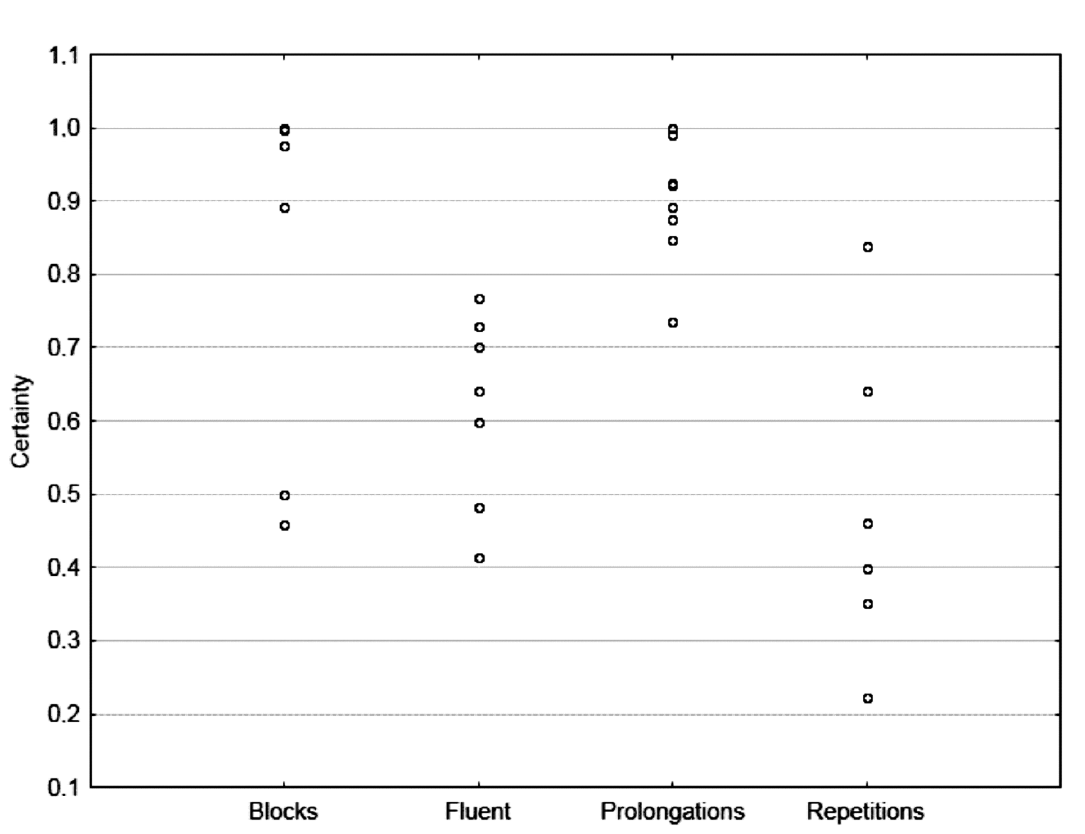
Figure 9. The certainty of classification concerning the fluency type.